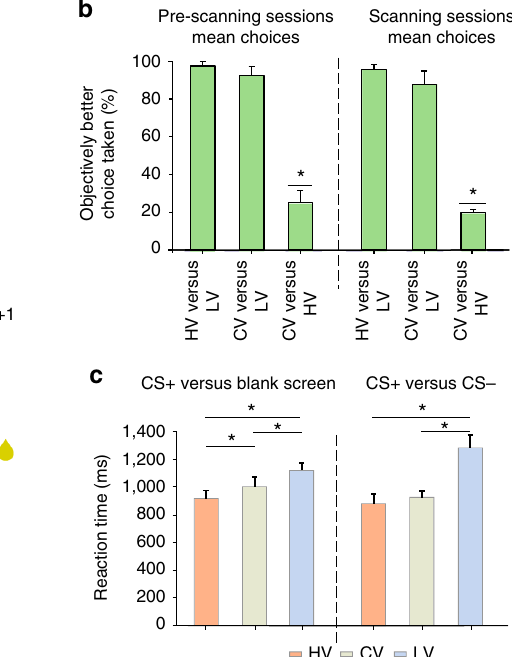
Fig. 2 Behavioral data — experiment 2. a Example trials from fMRI experiment. After an inter-trial interval (ITI) visual stimuli, associated with different outcomes, are presented. Choices were followed, after a mean 4 s delay, with either the delivery of two juice drops (either LV or HV), four juice drops (CV comprising both LV and HV), or no reward. On each trial animals either chose between two stimuli (two-option trials) each associated with reward, in the example illustrated one stimulus is associated with a single reward (left-side stimulus) and the other with a compound reward (right-side stimulus) or, on some trials (one-option trials), a single stimulus was presented on one side of the screen and an animal could either choose it by touching the button placed in front of it or reject it by touching the button in front of the blank side of the screen. b Frequency of choosing the objectively better of the two options. Animals preferred HV- to LV- stimuli and CV- to LV- stimuli but they did not prefer CV- to HV-stimuli. c Reaction times (RTs) of choices between a CS+ (i.e., HV, CV, LV) and an unrewarded stimulus (the blank side of the screen or a CS − ). RTs decreased with expected value of the